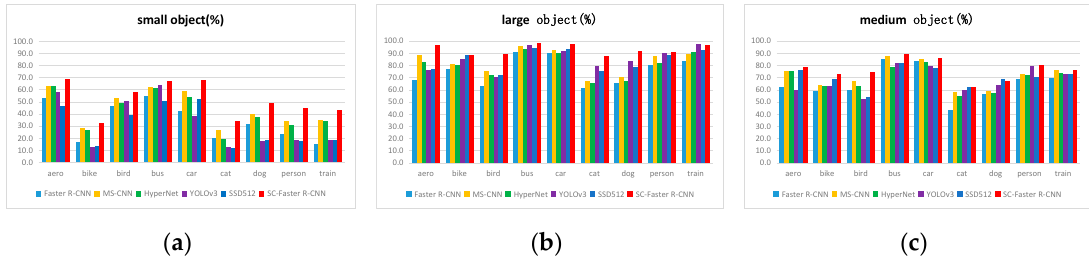
Figure 7. Detection of ( a ) small, ( b ) medium, and ( c ) large objects in test set of 07 + 12 dataset by various deep neural network algorithms.